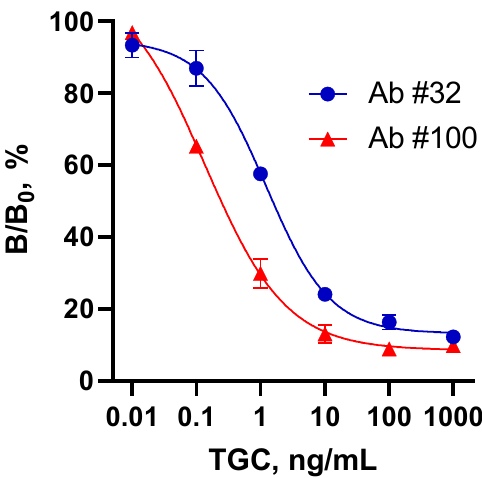
Figure 3. Standard curves for TGC determination in group-specific (Ab#32) and TGC-selective (Ab#100) antibody-based ELISAs. Each point is represented by an average value (n = 3) ± standard deviation. Table 2. Comparative analytical characteristics of immunoassays for